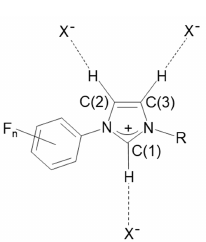
Figure 2. Structure of the cation of 1 indicating the positions of the closest bromide anions. Thermal ellipsoids are at the 50% level. Hydrogen atoms, except those involved in hydrogen bonding, are omitted for clarity. Figure 3. Structure of cation 2 indicating the positions of the closest bromide anions. Thermal ellip- soids are at the 50% level. Hydrogen atoms, except those involved in hydrogen bonding, are omitted for clarity.